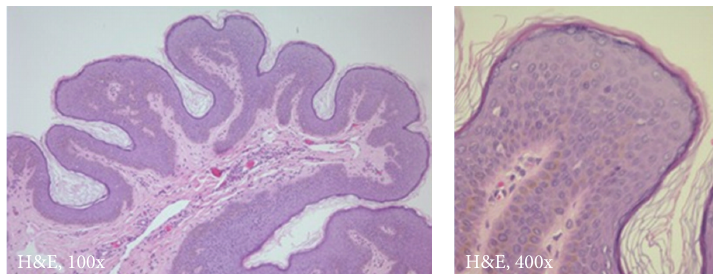
Figure 3: Histopathological examination revealed epidermal acanthosis, papillomatosis, and